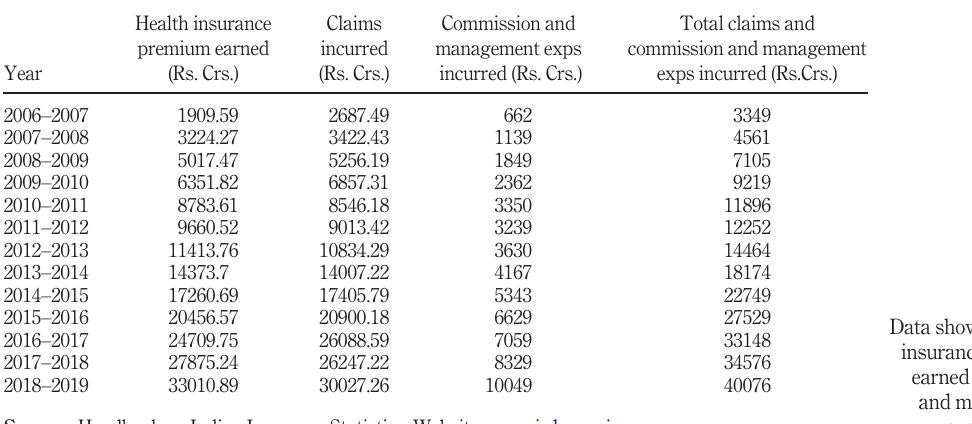
Table 1. Data showing